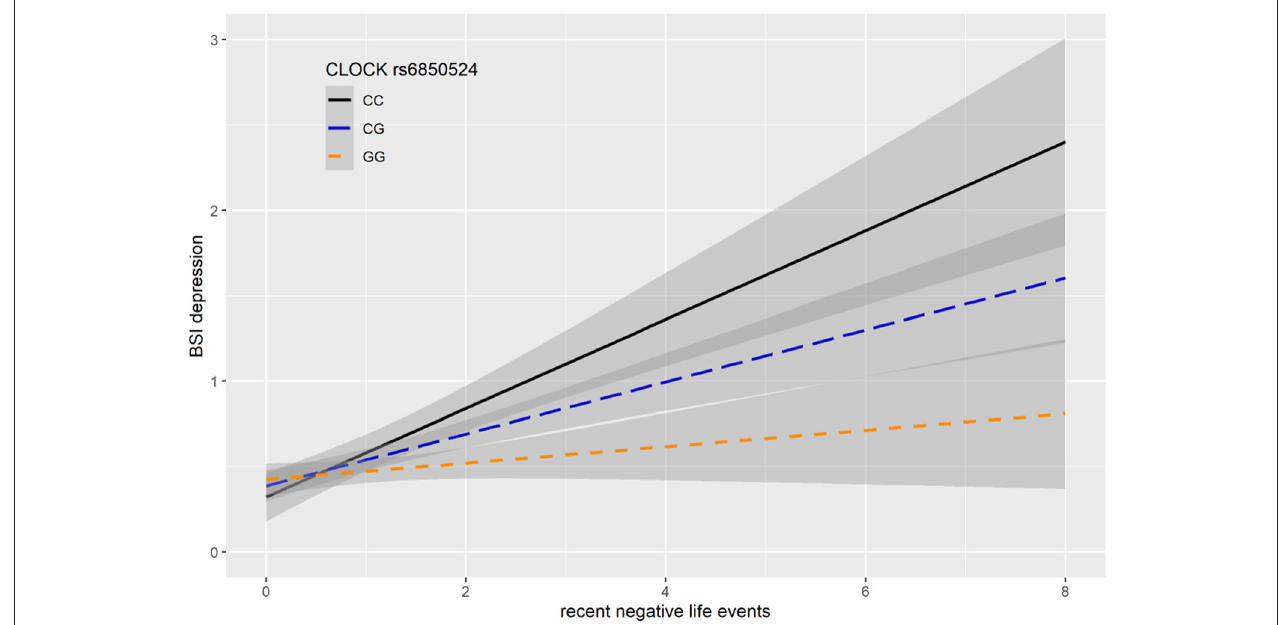
FIGURE 3 | Linear regression indicated a significant interaction between top SNP rs6850524 of a clump containing 94 SNPs in the CLOCK gene and exposure to recent life events (RLE) on current depression symptoms (BSI-dep) in the additive model, with the minor C allele as a risk allele. Linear regression indicated a significant interaction between CLOCK rs6850524 genotype and recent stressful life events (RLE) on current depression scores according to the additive model as top SNP ( p = 0.0004, FDR Q = 0.013). Presence of the minor C allele was associated with higher depression scores in subjects exposed to more severe recent life events conveying a risk effect. On the vertical axis weighted depression (BSI-Dep) scores are shown. The horizontal axis shows recent life events (RLE) occurring within the past year as measured by the List of Threatening Experiences ( 31). BSI-Brief symptom inventory. Gray shading denotes